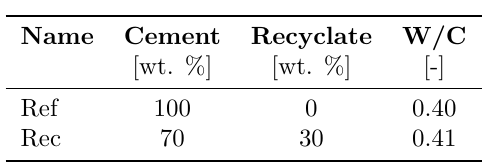
Table 1. Weight proportions of cement